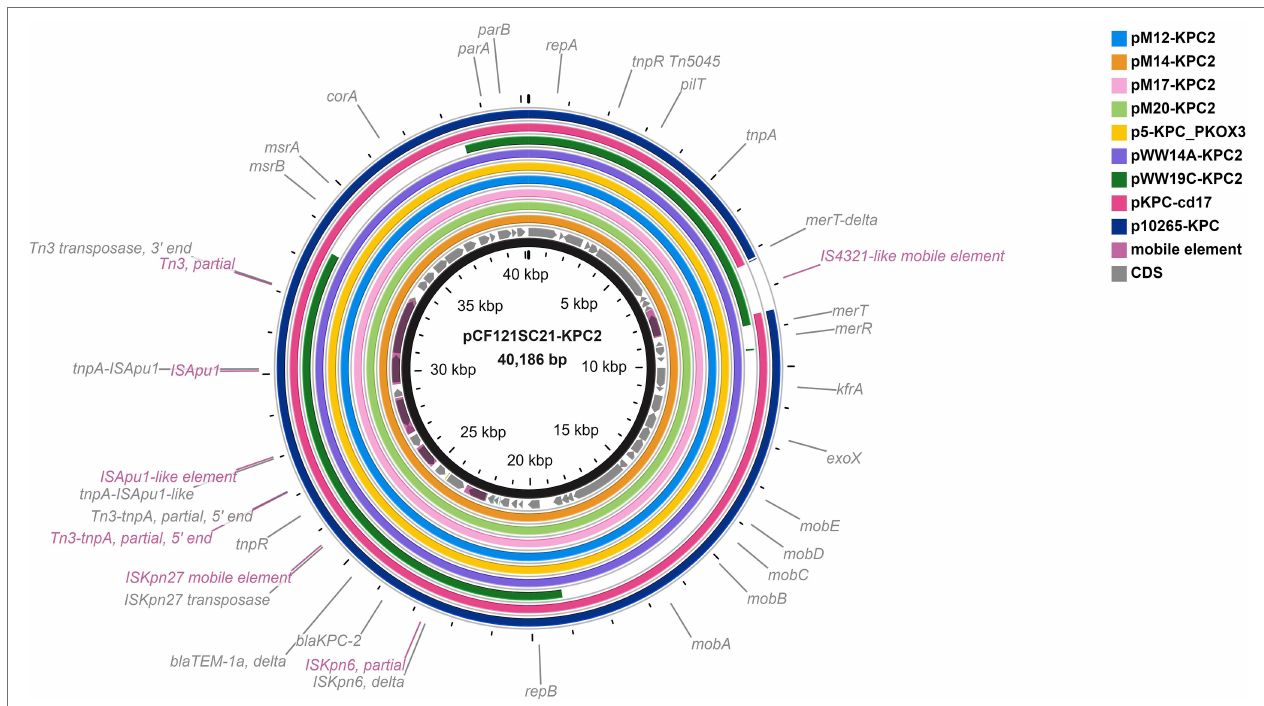
FIGURE 2 | Comparison of plasmids pM12-KPC2, pM14-KPC2, pM17-KPC2, and pM20-KPC2 with IncP6 bla KPC-2 -bearing plasmids of environmental and clinical origin described in the literature: pCF121SC21-KPC2 from Spanish wastewater Citrobacter freundii (Genbank accession no. LT992437; Yao et al., 2017), pKOX3- P5-KPC from clinical Klebsiella oxytoca in China (GenBank accession no. KY913901; Wang et al., 2017), pWW14A-KPC2 from wastewater Klebsiella quasipneumoniae in Argentina (GenBank accession no. CP080103; Ghiglione et al., 2021), pWW19C-KPC2 from wastewater Enterobacter asburiae in Argentina (GenBank accession no. CP080110; Ghiglione et al., 2021), p10265-KPC from clinical Pseudomonas aeruginosa in China (GenBank accession no. KU578314; Dai et al., 2016), and pKPC-cd17 from Aeromonas sp. from hospital environment in United States (GenBank accession no. CP026224) which is 100% identical to the bla KPC-2 -carrying plasmid in Klebsiella oxytoca from Spanish hospitals (Pérez-Vazquez et al., 2019). The plasmid pCF121SC21-KPC2 was taken as a reference plasmid (black